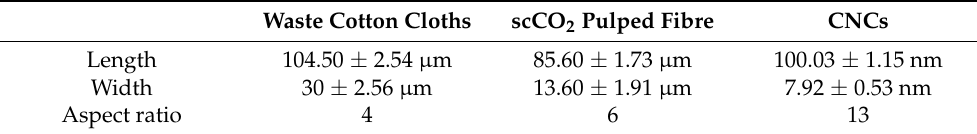
Table 1. Particle size of waste cotton cloths, scCO 2 pulped fibre, and